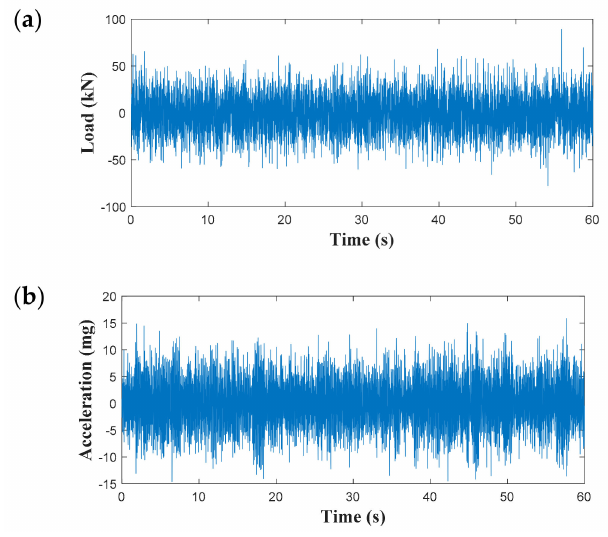
Figure 5. Examples of random excitation—( a ) load on node 1 and ( b ) acceleration response of node 1.